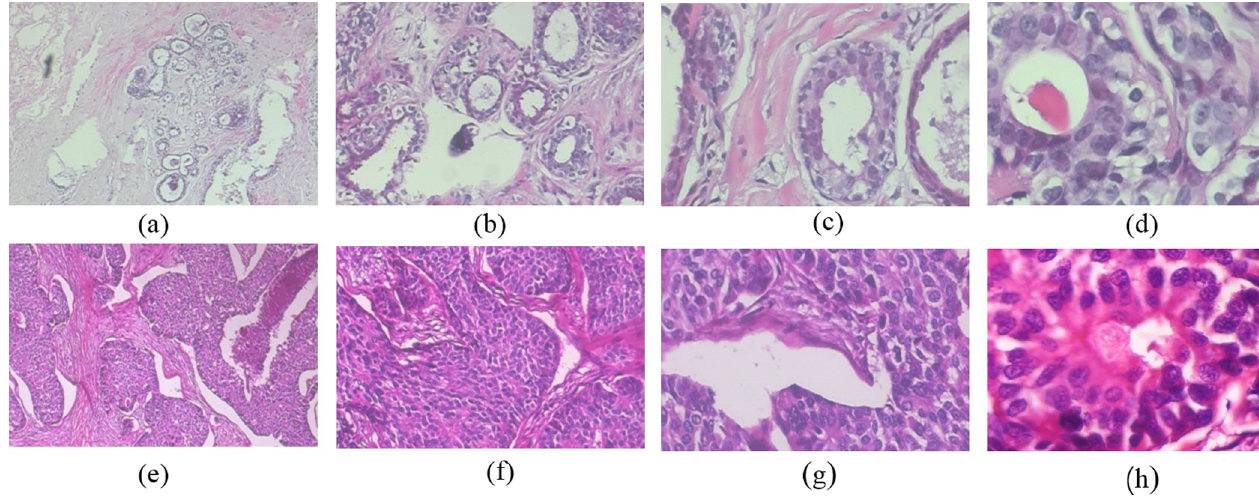
Fig 7. Image samples from BreakHis dataset. (a)~(d) benign tumor and (e)~(f) malignant tumor with the magnification factor of 40 × , 100 × , 200 × , 400 × .